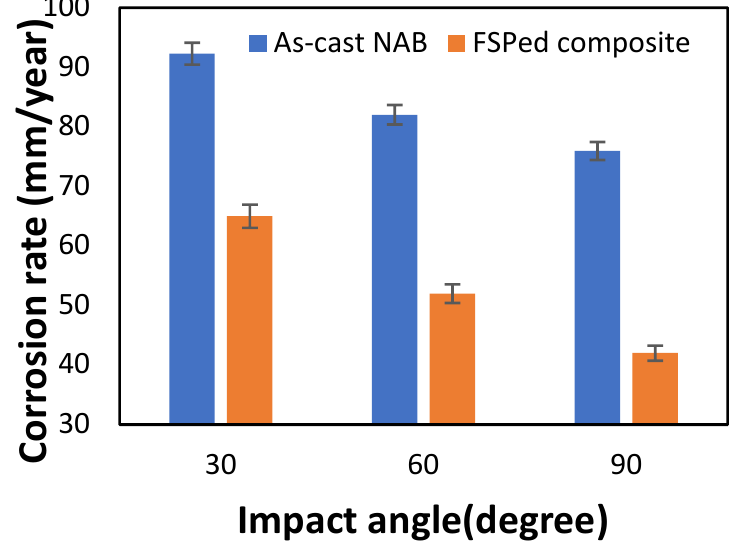
Figure 10. Corrosion rate vs. impact angle.